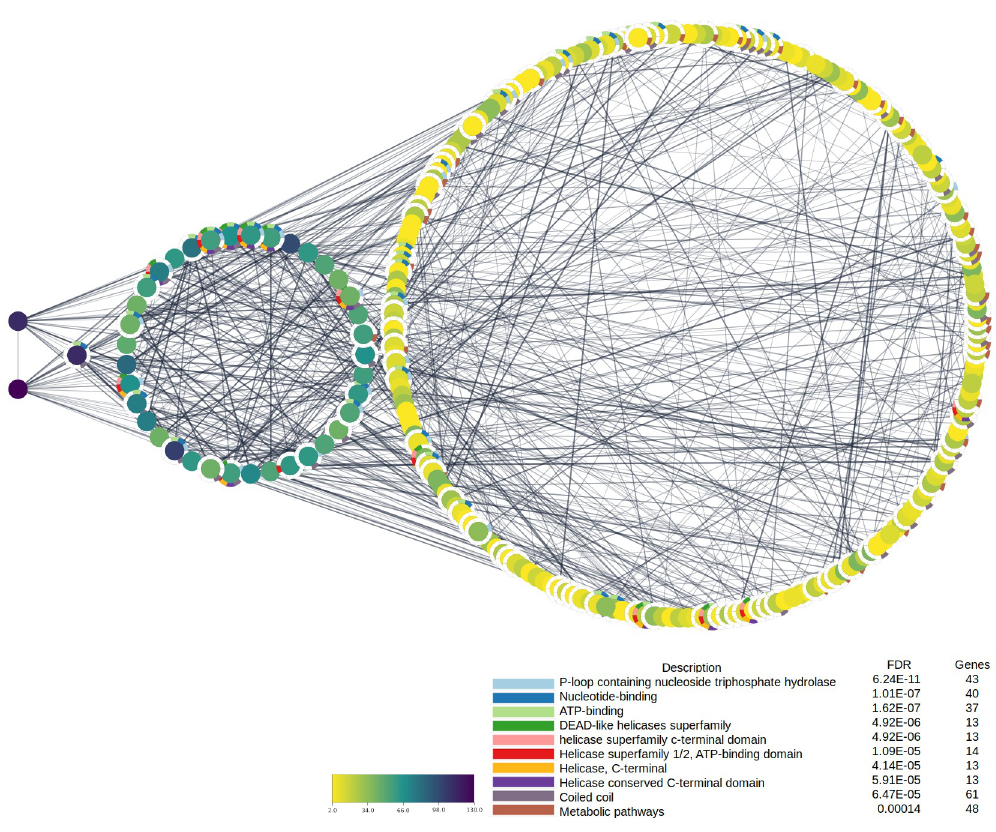
Fig 6. Protein-protein interaction for TE-gene